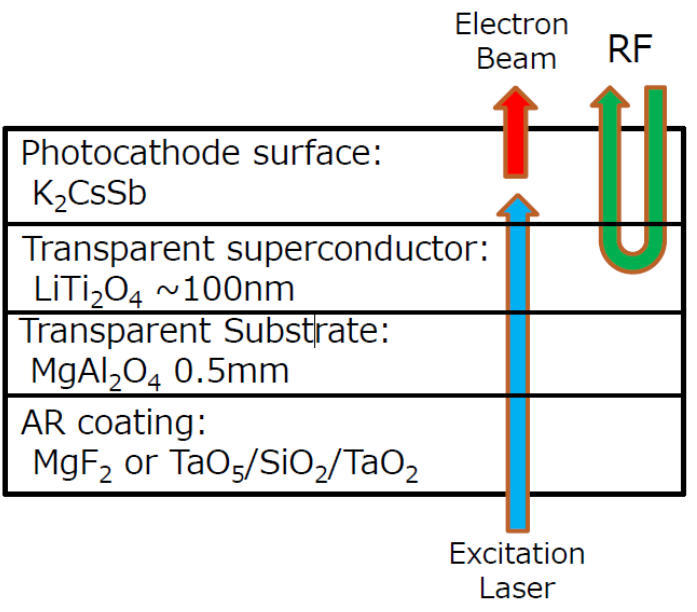
Figure 11. Working concept of transparent photocathode for KEK SRF gun [49].